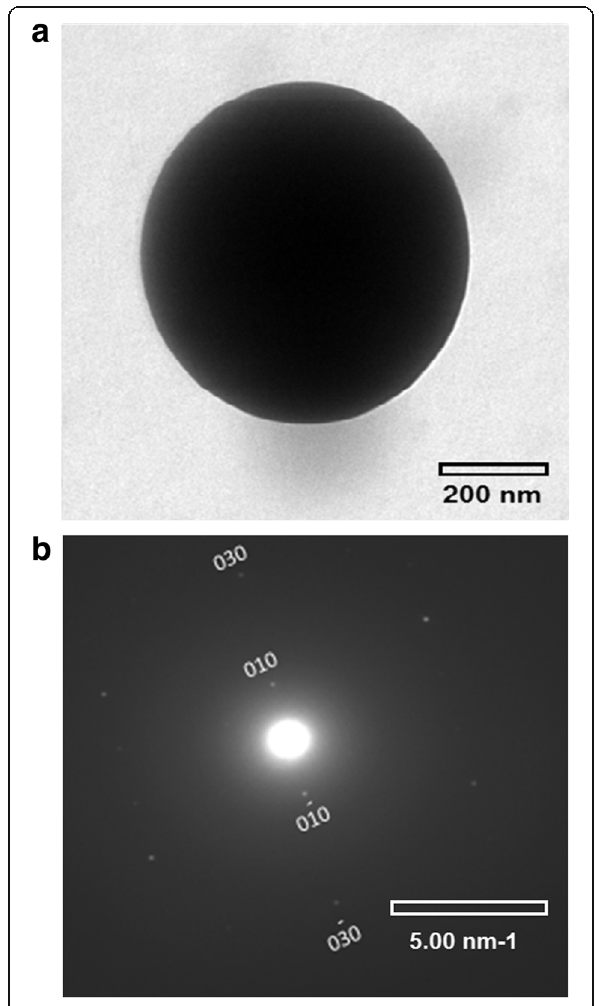
Fig. 7 a TEM image and b SAED of a ball-like P3HT domain in P3HT-PMMA (1:50 weight ratio) blend sample